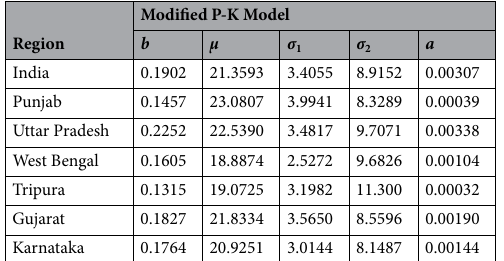
Table 6. Estimates of parameters of Modified P-K Model for India and 6 selected states.